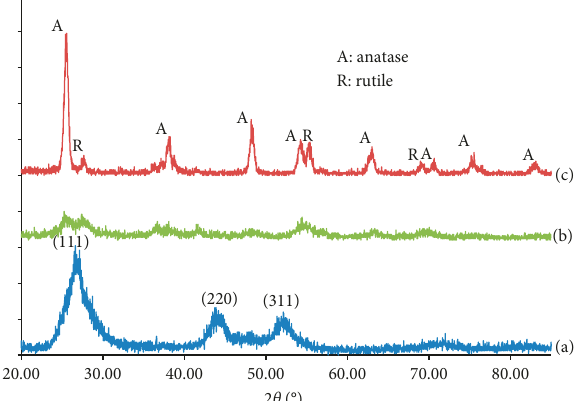
Figure 4: XRD patterns of (a) PVP-capped CdS, (b) CdS/TiO hybrid, and (c) TiO 2